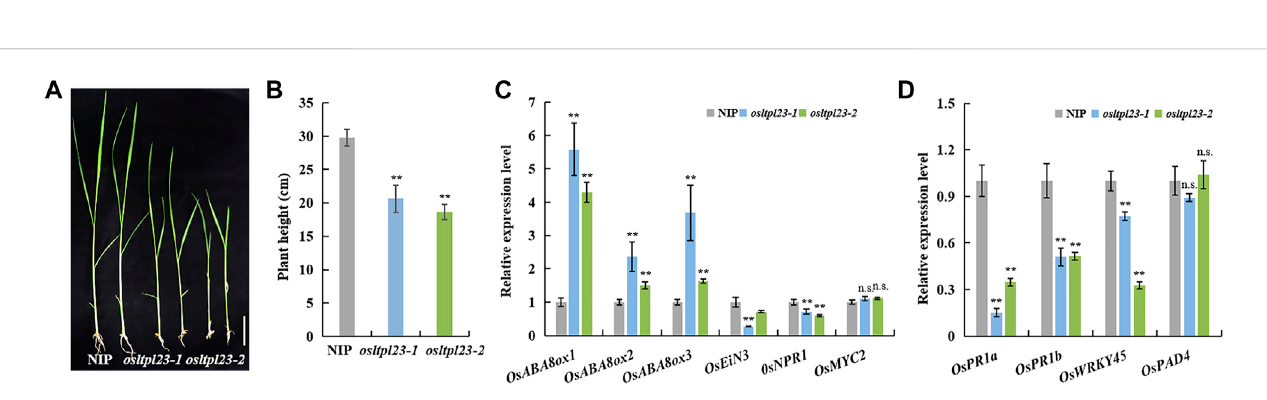
FIGURE 7 The osltpl23 mutants have weakened seedling growth. (A) Growth potential of NIP, osltpl23-1 and osltpl23-2 mutants after 14 days. Scale bar, 4 cm. (B) Theplantheightof14 daysoldseedlingsinNIP, osltpl23-1 and osltpl23-2 mutants.Scalebar,4 cm. (C) ResponsiveexpressionofABA-,ethylene-,JA-andSA- related genes of 14 days old seedlings in NIP, osltpl23-1 and osltpl23-2 mutants. (D) Expression level of defense-responsive genes of 14 days old seedlings in NIP, osltpl23-1 and osltpl23-2 mutants.Valuesarethemean±standarddeviationsofthreebiologicalreplicates.Signi fi canceweregeneratedbyStudent ’ s t-test with * p < .05 and ** p <